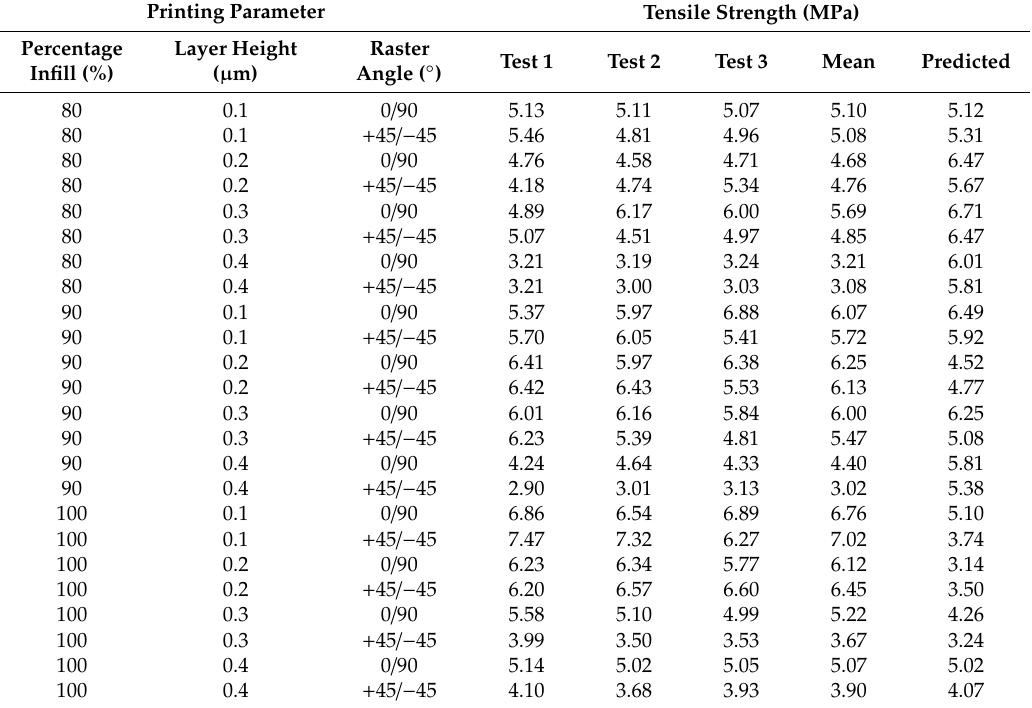
Table 3. Input process parameter and corresponding experimental and predicted tensile